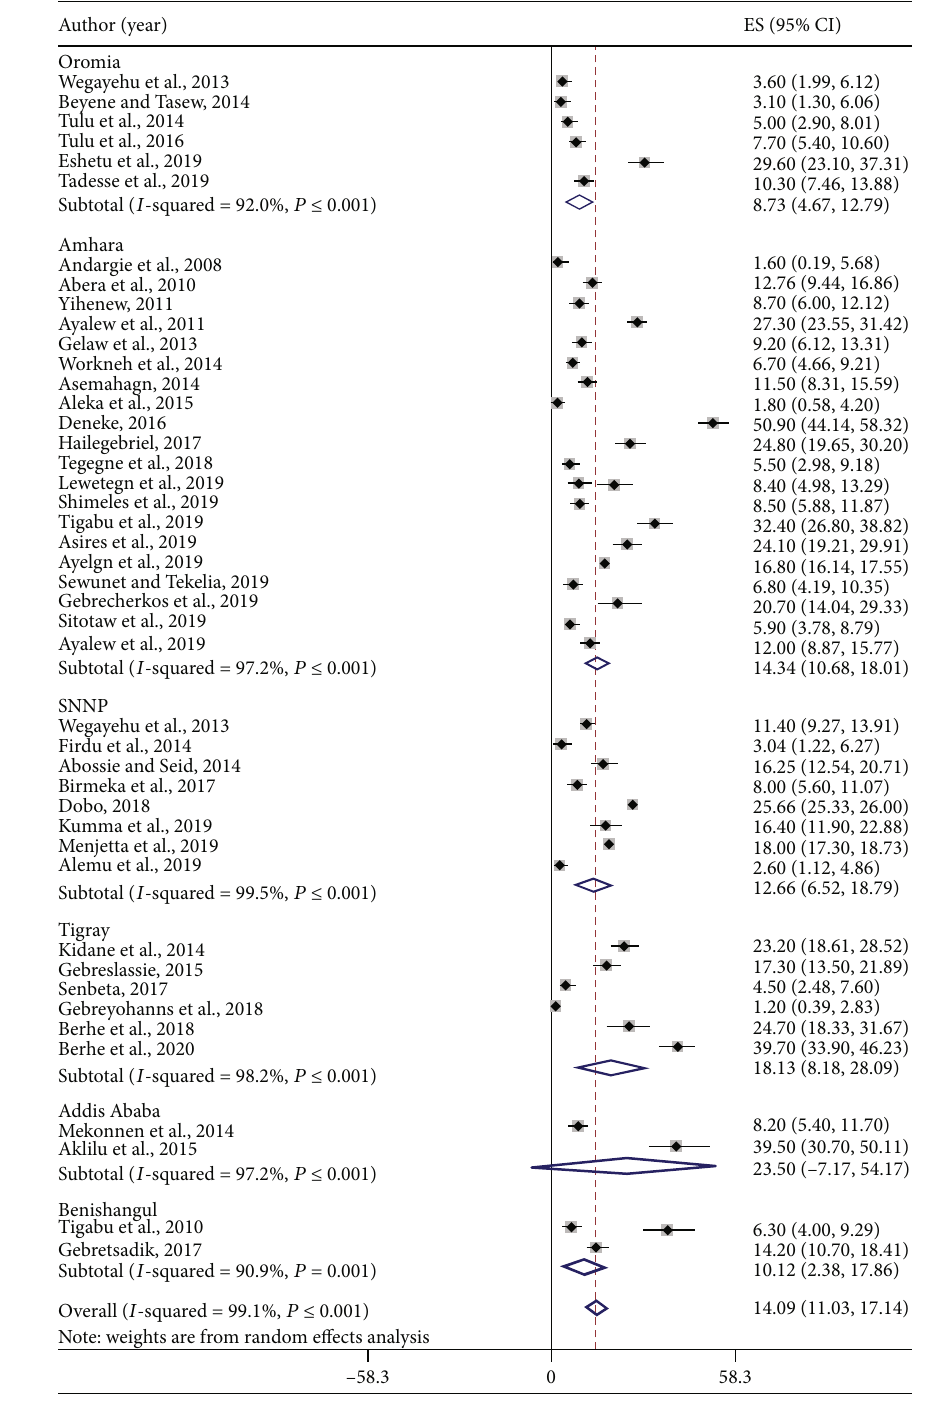
Figure 3: The pooled prevalence of E . histolytica / dispar among study participants in